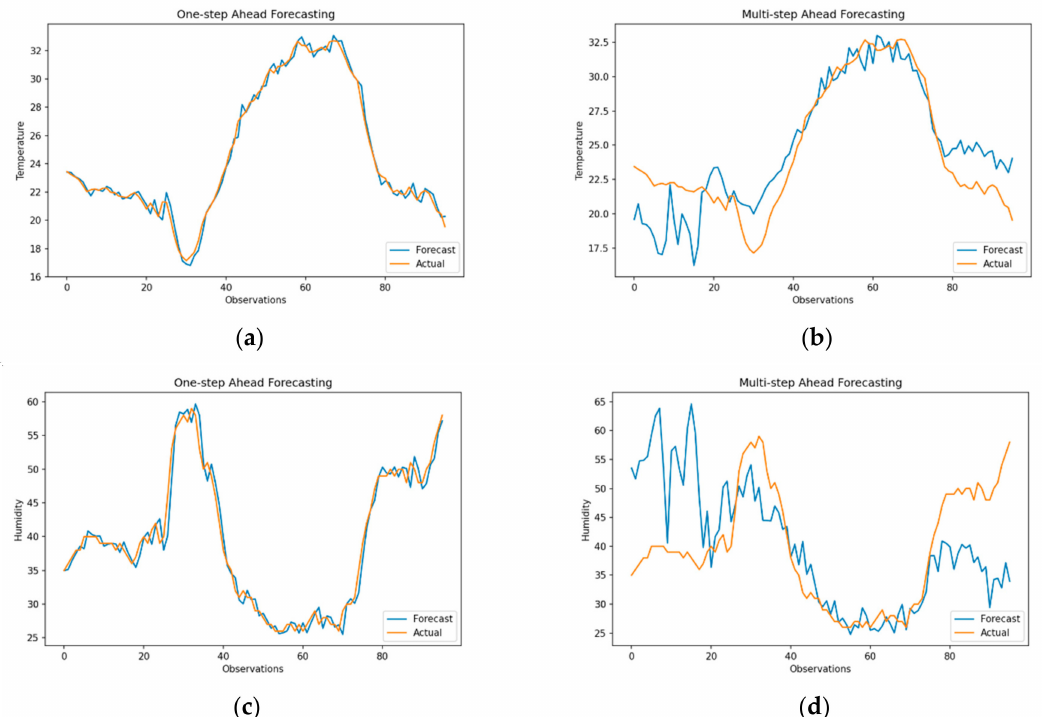
Figure 5. Forecast using Seasonal Auto-Regressive Integrated Moving Average (SARIMA) ( a ) One-step ahead Temperature ( RMSE = 0.513) ( b ) Multi-step ahead Temperature ( RMSE = 3.425) ( c ) One-step ahead Humidity ( RMSE = 2.034) ( d ) Multi- step ahead Humidity ( RMSE = 10.219) ( top-left, top-right, bottom-left, bottom-right